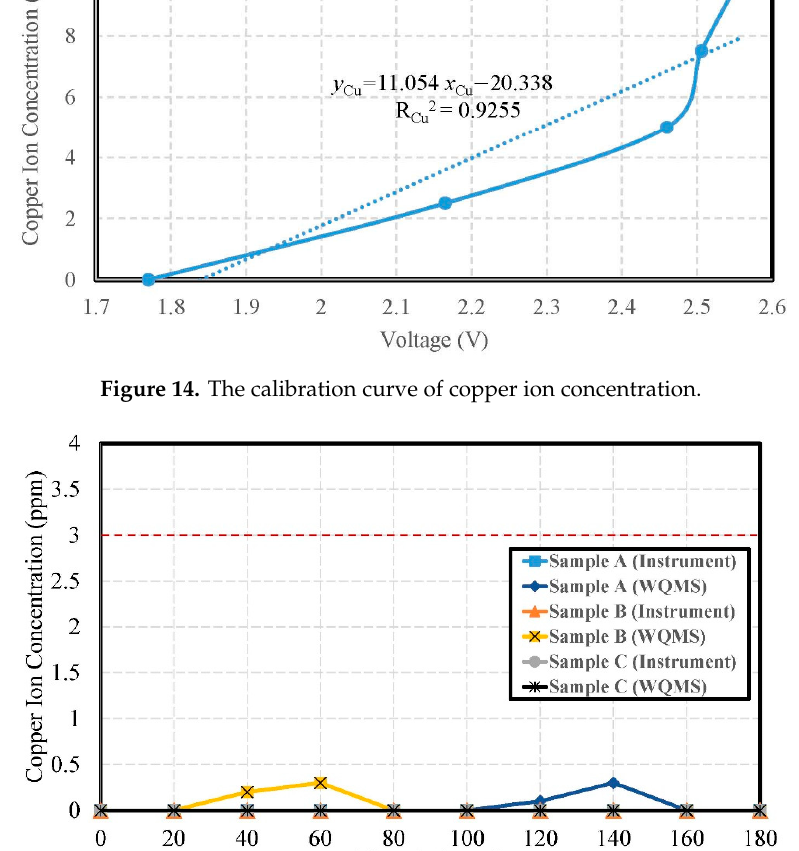
Figure 14. The calibration curve of copper ion concentration.